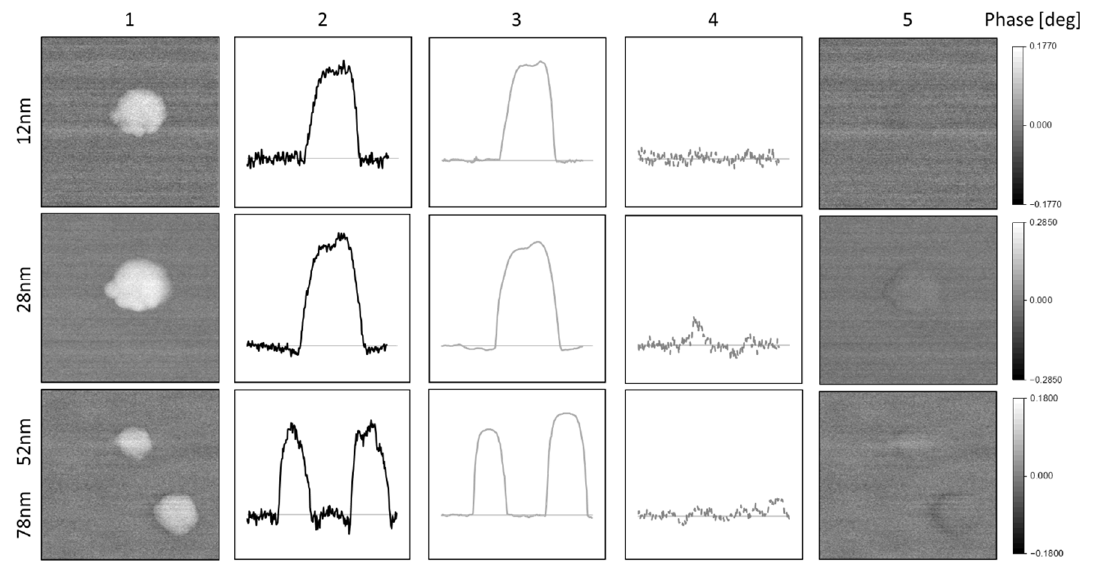
Figure 5. Data Fusion of different polystyrene capsules (top to bottom): ( 1 ) measured phase shift, ( 2 ) cross-section of measured phase shift, ( 3 ) calculated phase shift based on topographic cross-section, ( 4 ) cross-section of resulting phase shift by data fusion, ( 5 ) resulting phase image. (Silicon substrate; V CPD = 0.55 V − 1 V; z = 50 nm; r tip = 80 nm).